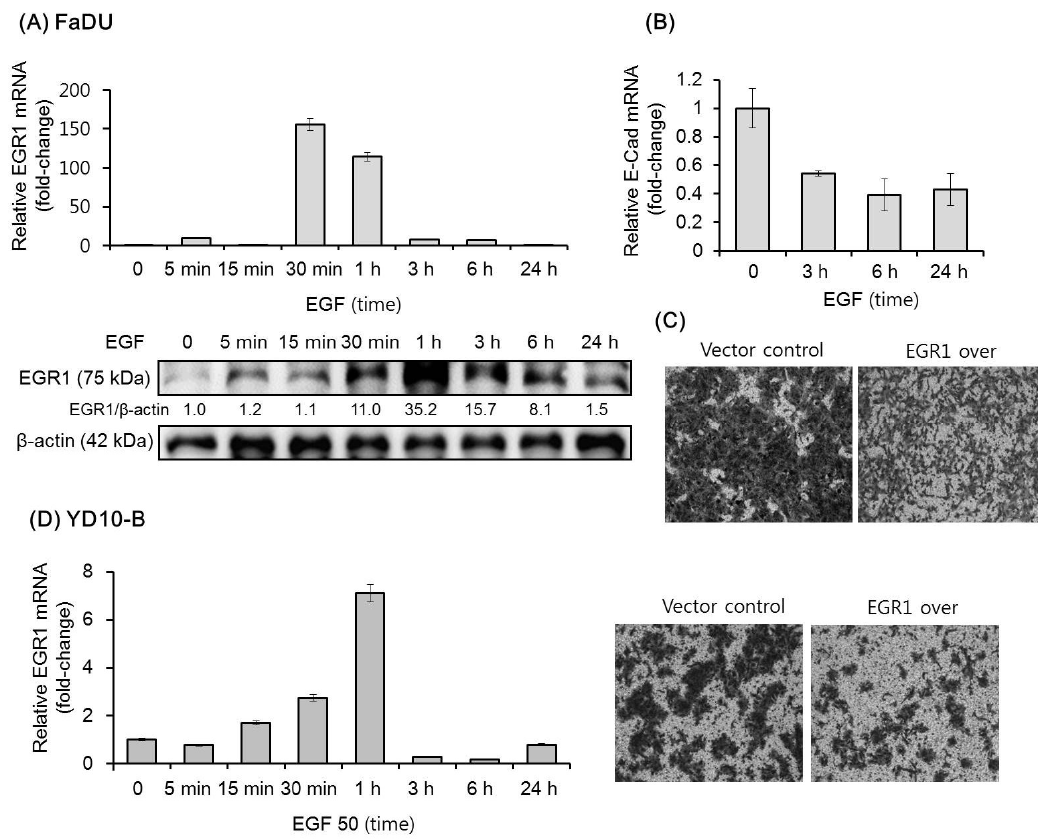
Figure 1. Effect of Epidermal Growth Factor (EGF) on the expression of EGR1 in head and neck squamous cell carcinoma (HNSCC) cells. ( A ) Time-dependent effect of EGF (50 ng/mL) administration over 24 h on the expression of EGR1 mRNA and protein as assessed by qPCR and Western blot analysis. ( B ) E-cadherin mRNA levels were analyzed under the same conditions. ( C ) Transwell Matrigel invasion assay was performed to assess the effect of EGR1 overexpression (over) on FaDU cell invasion. EGR1 overexpression vector- or control vector-transfected FaDU cells were added to each Matrigel-coated transwell. After culturing for 48 h, the cells were stained with 0.2% crystal violet in 10% ethanol, and cell invasion was monitored by phase-contrast microscopy (5 × magnification). ( D ) EGF-dependent EGR1 mRNA upregulation and the effect of EGR1 overexpression on Transwell Matrigel invasion using YD-10B cells were evaluated using the same conditions (5 × magnification). The results shown are from two or three independent experiments, with each bar representing the standard deviation. Please add magnification for Figure 1 C and